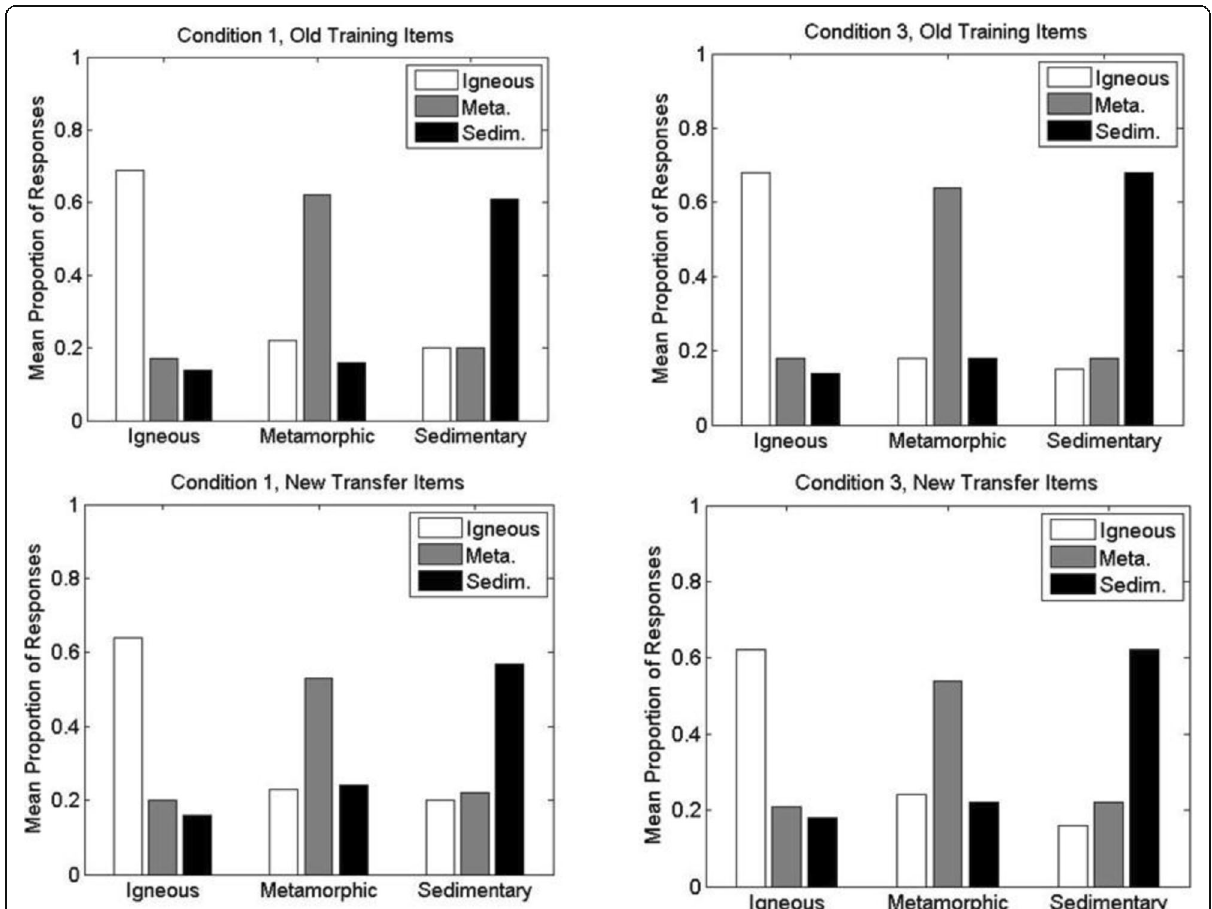
Fig. 10 Yoked experiment 1B: mean proportion with which members of each high-level category were classified into the alternative high-level categories during the classification test phase of conditions 1 and 3. (Left panels) Condition 1; (right panels) condition 3; (upper panels) old training items; (lower panels) new transfer items. For example, within each panel, the white bar to the far left indicates the mean proportion with which members of the high-level igneous category were correctly classified as igneous, whereas the adjacent gray bar indicates the mean proportion with which members of the igneous category were incorrectly classified as metamorphic (Meta.). Sedim.